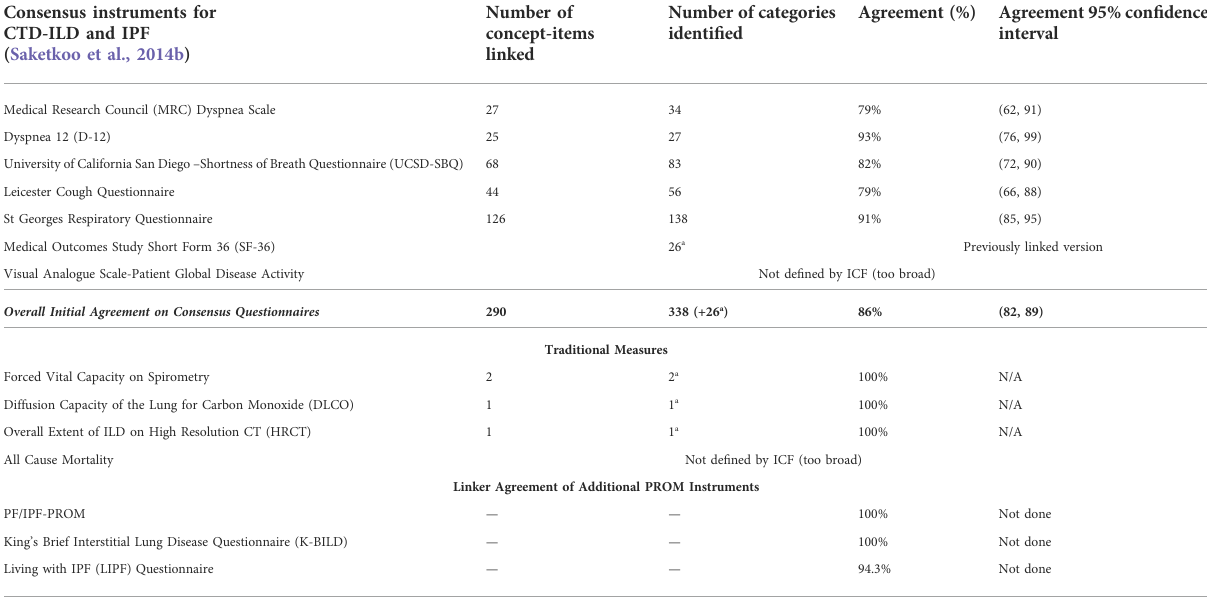
TABLE 3 Instruments from the previously published CTD-ILD and IPF minimum core sets for clinical trials with instrument comparison and inter- reviewer agreement. ( Courtesy of LA Saketkoo, with permission, rights reserved ) Consensus instruments for CTD-ILD and